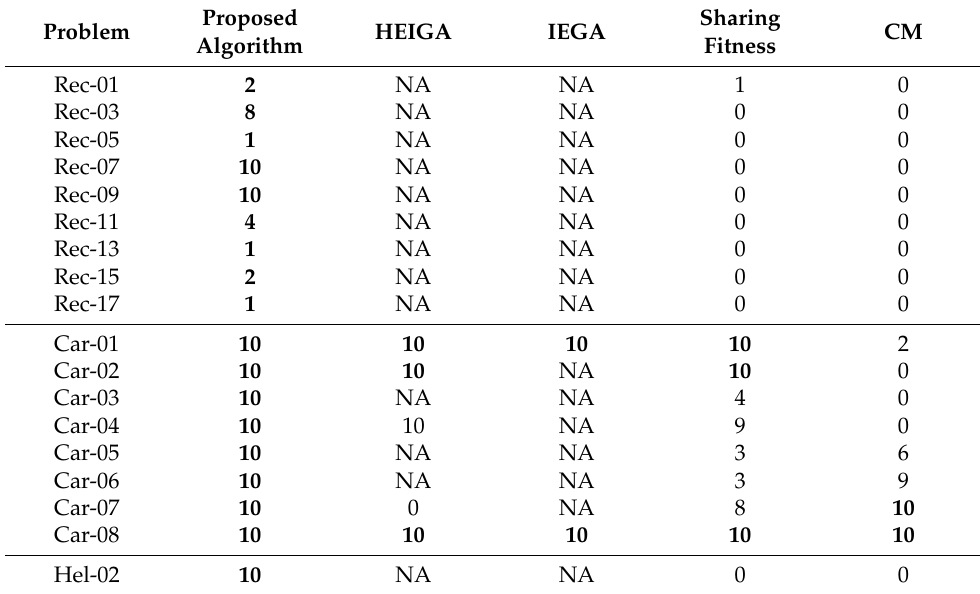
Table 4. Number of simulations in which the algorithms were able to converge to the best optimal solution ( N C